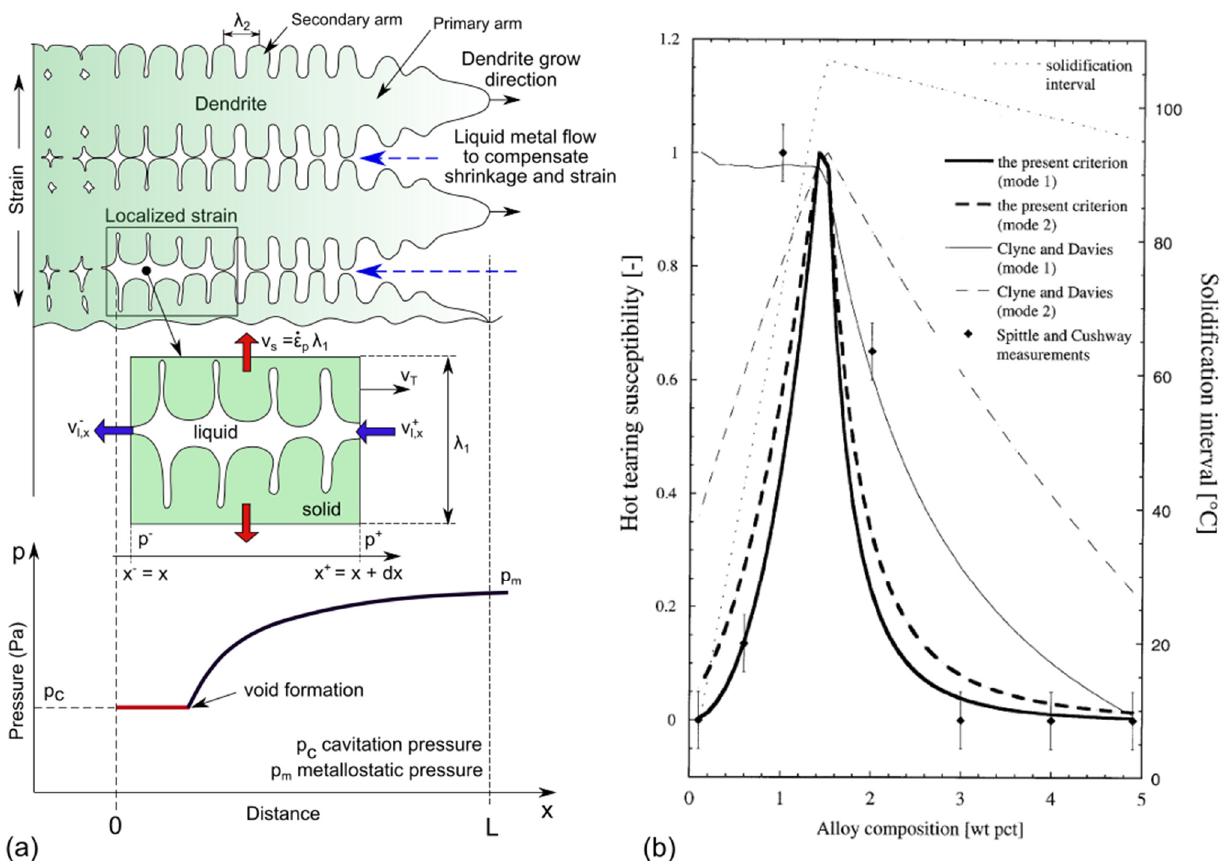
Figure 15. Representation of ( a ) hot tear formation in columnar dendritic growth with pressure conditions; and ( b ) the HCS criterion. Based on [190]. Notations: λ 1 is primary dendrite arm spacing, λ 2 is secondary dendrite arm spacing, v s shrinkage velocity, v l velocity of fluid, v T is solidification rate, and ( d ɛ / dt ) p is deformation or plastic strain rate.